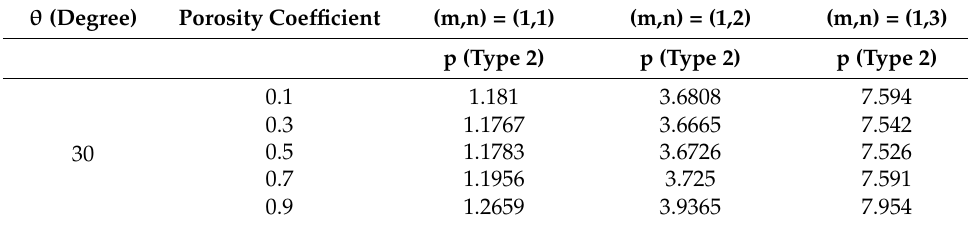
Table 4. The effect of the circumferential wave number.